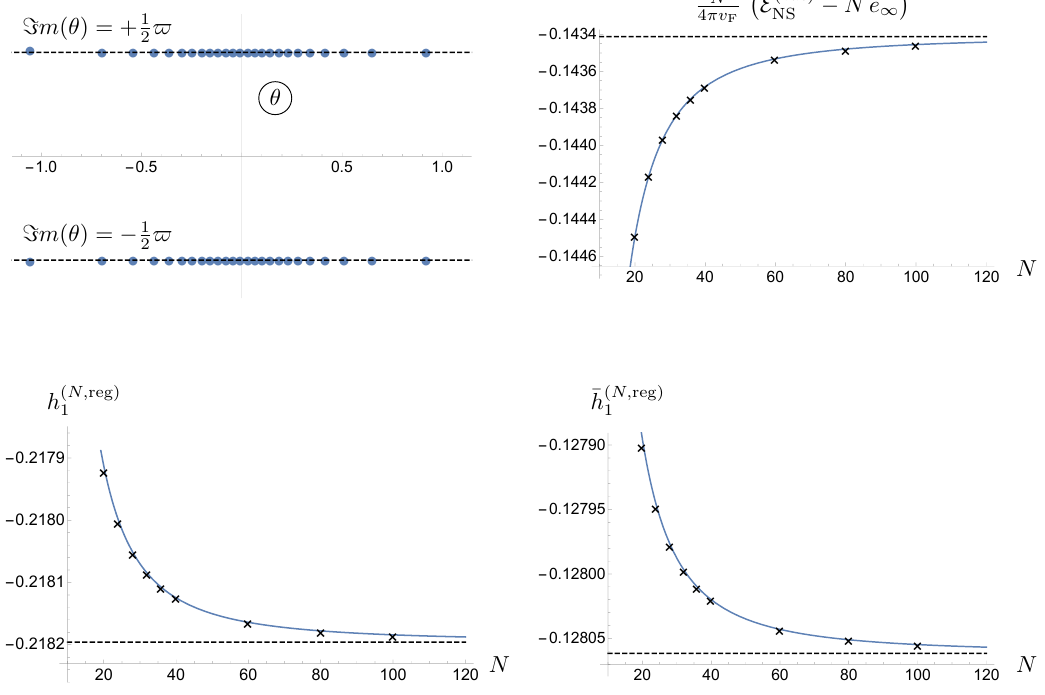
. The black NS (cid:0) (cid:1) cos( $ ) = N − (1 − β 2 ) h ( N ) . 1 1 sin( πβ 2 / 2)